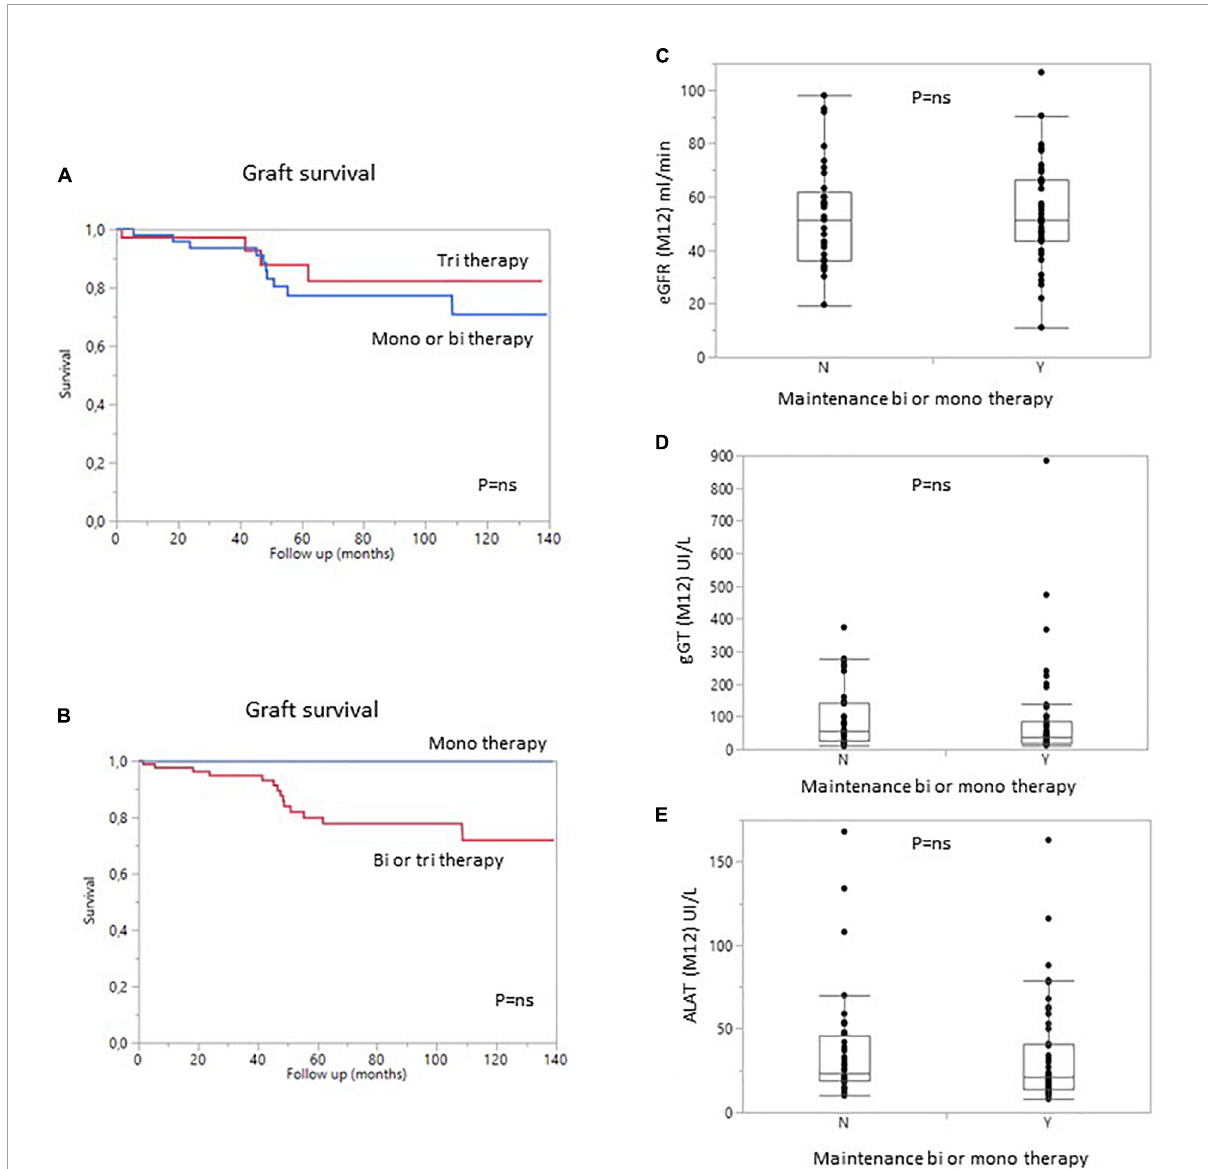
FIGURE5 Graft survival (death-censored) according to the number of immunosuppressive drugs in the regimen at 1 year. (A) Patients with bi- or monotherapy (blue) vs. triple immunosuppression (red). (B) Patients with monotherapy (blue) vs. bitherapy or triple immunosuppression (Red). (C) Estimated GFR, (D) gamma GT levels, and (E) ALAT levels in patients on bi- or monotherapy vs. triple immunosuppression at 1 year. Y, yes; N,